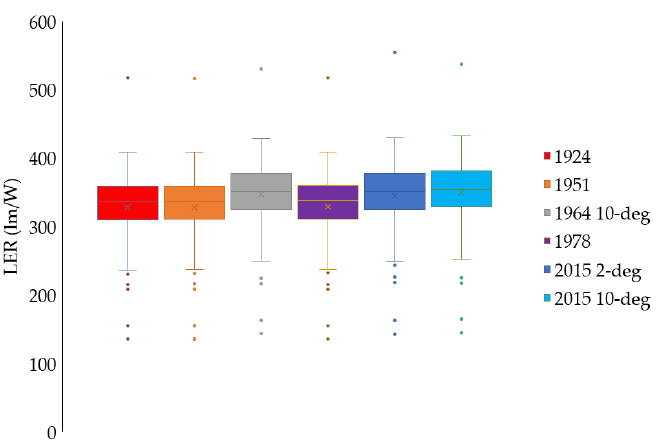
Figure 3. Box plot of LER for six spectral luminous efficiency functions .